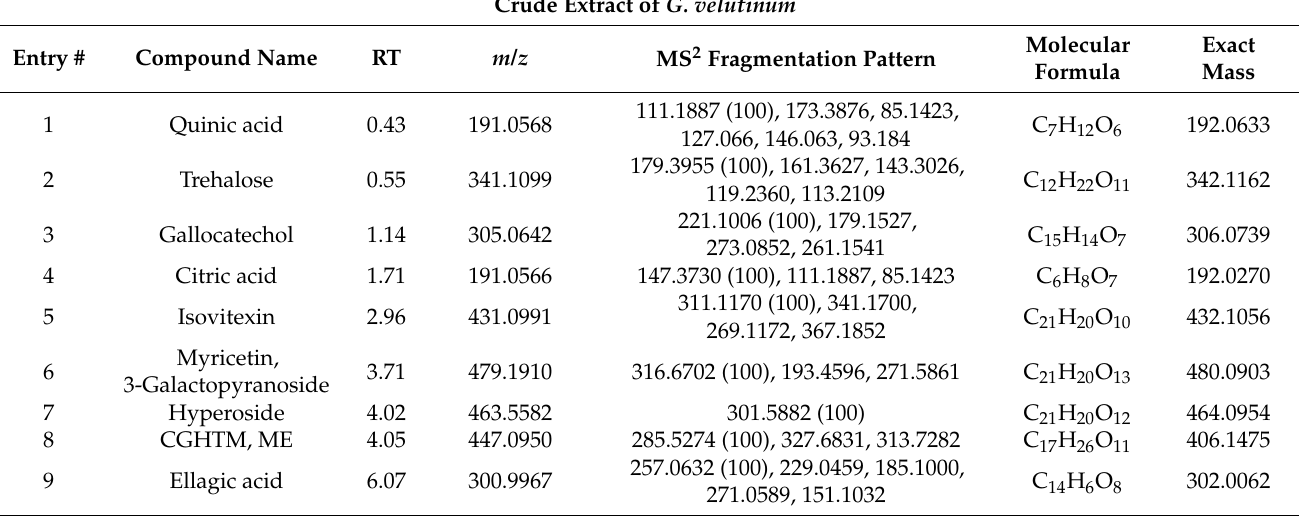
Figure 3. Classes of chemical constituents were identified using GNPS molecular networking and MolnetEnhancer technique to identify the chemical space present within ethyl acetate fraction of G. velutinum leaves. Table 3. The phytochemical profile of G. velutinum leaves was established with the help of LC- MS/MS-based molecular networking. Crude Extract of G. velutinum